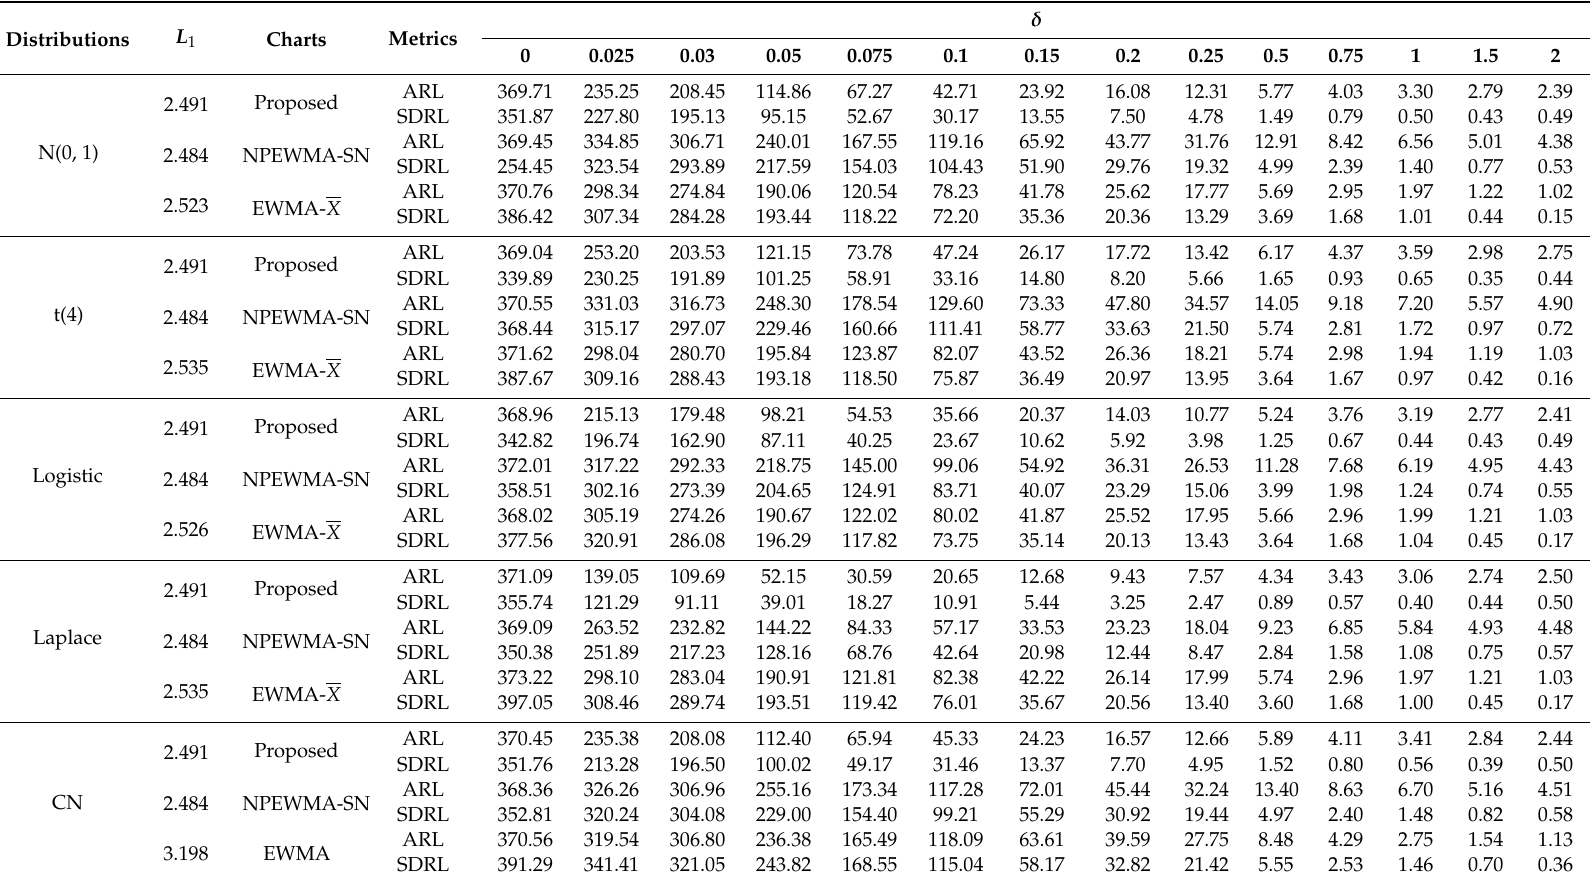
Table 7. Comparisons of the proposed and alternatives at λ = 0.05 and n =